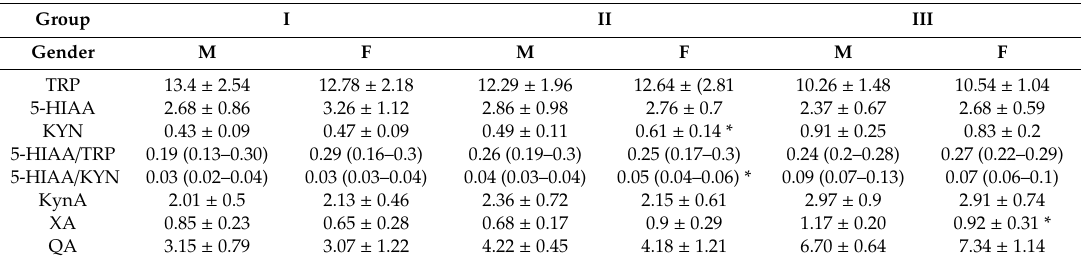
Table 4. Urinary levels of tryptophan (TRP) and its metabolites expressed in milligram per gram of creatinine and their ratios in healthy young adult individuals (group I) and in the elderly without (group II) and with mood disorders (group III) 1